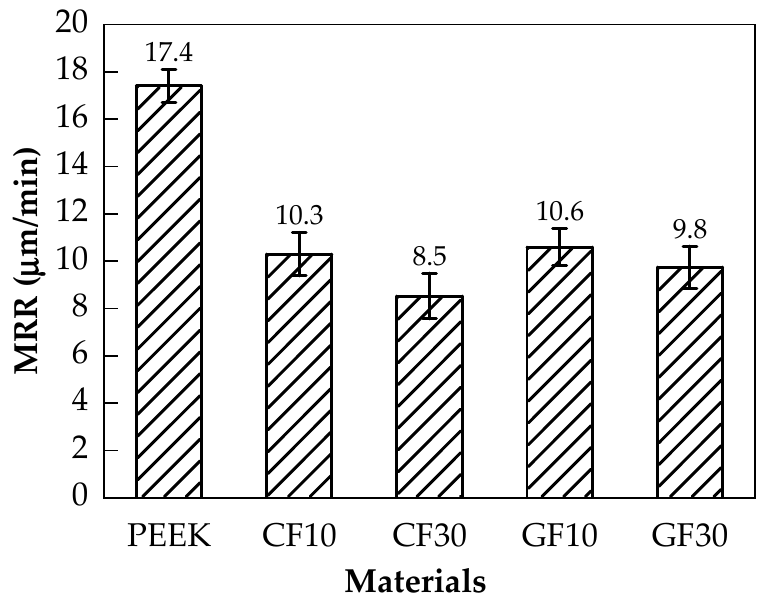
Figure 5. The material removal rates of the pure PEEK and the fiber-reinforced PEEK. The surface roughness reflects the quality of the lapping process. The results of surface roughness after the lapping process are shown in Figures 6 and 7. The surface roughness of fiber-reinforced PEEK showed a downward trend with the particle size of the abrasive paper decreasing. When the mesh sizes of abrasive paper were small (#180, #240, #320), the lapped surface roughness was poor, and in addition, the downward trend of the surface roughness was obvious. When the abrasive paper of the #1000 mesh size was applied, the surface roughness improved and the downward trend flattened. As shown in Figure 6a, with the same mesh size of the abrasive paper, the surface roughness of CF10/PEEK was lower than the GF10/PEEK, which was the same trend between the CF30/PEEK and GF30/PEEK. The CF/PEEK showed better lapping machin- ability than the